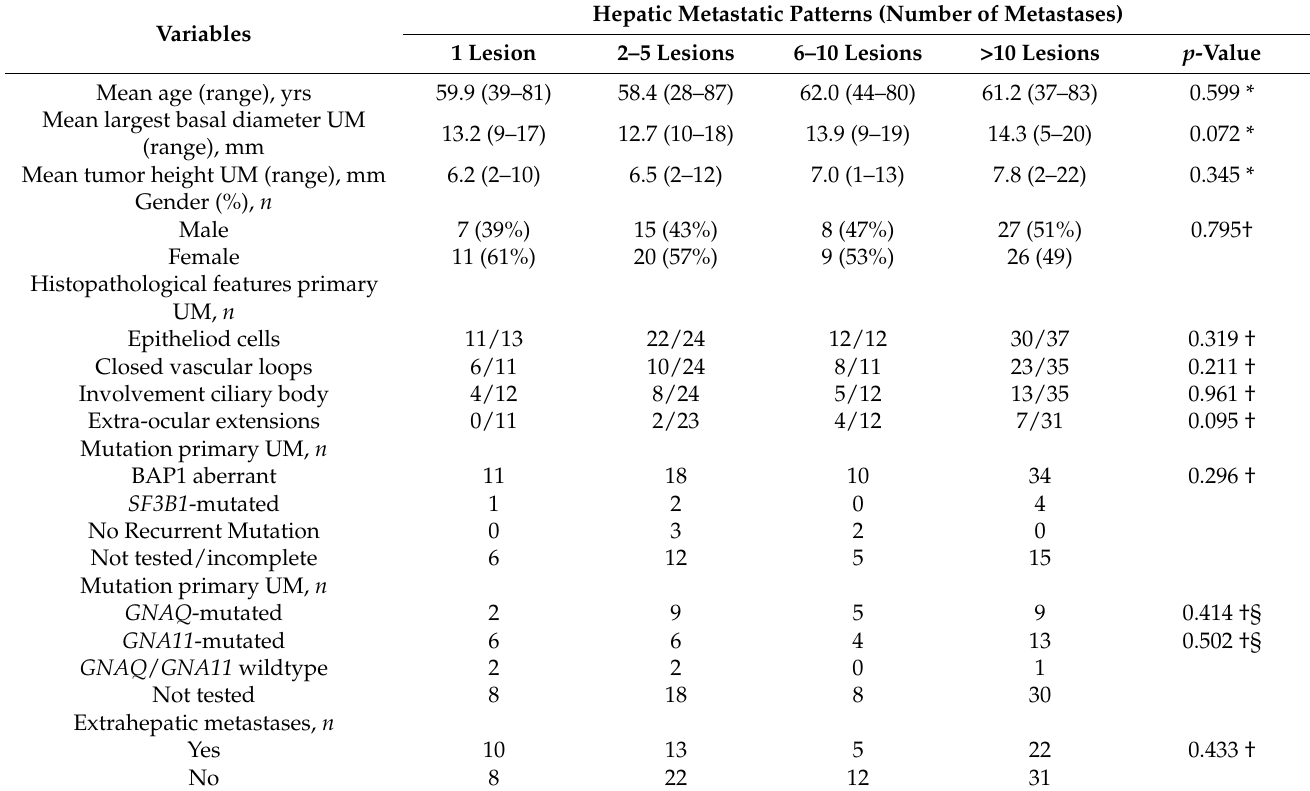
Table 2. Correlation between the number of metastatic lesions and Other Clinical, Histopathological, and Genetic Features. Hepatic Metastatic Patterns (Number of Metastases) Variables 1 Lesion 2–5 Lesions 6–10 Lesions >10 Lesions p